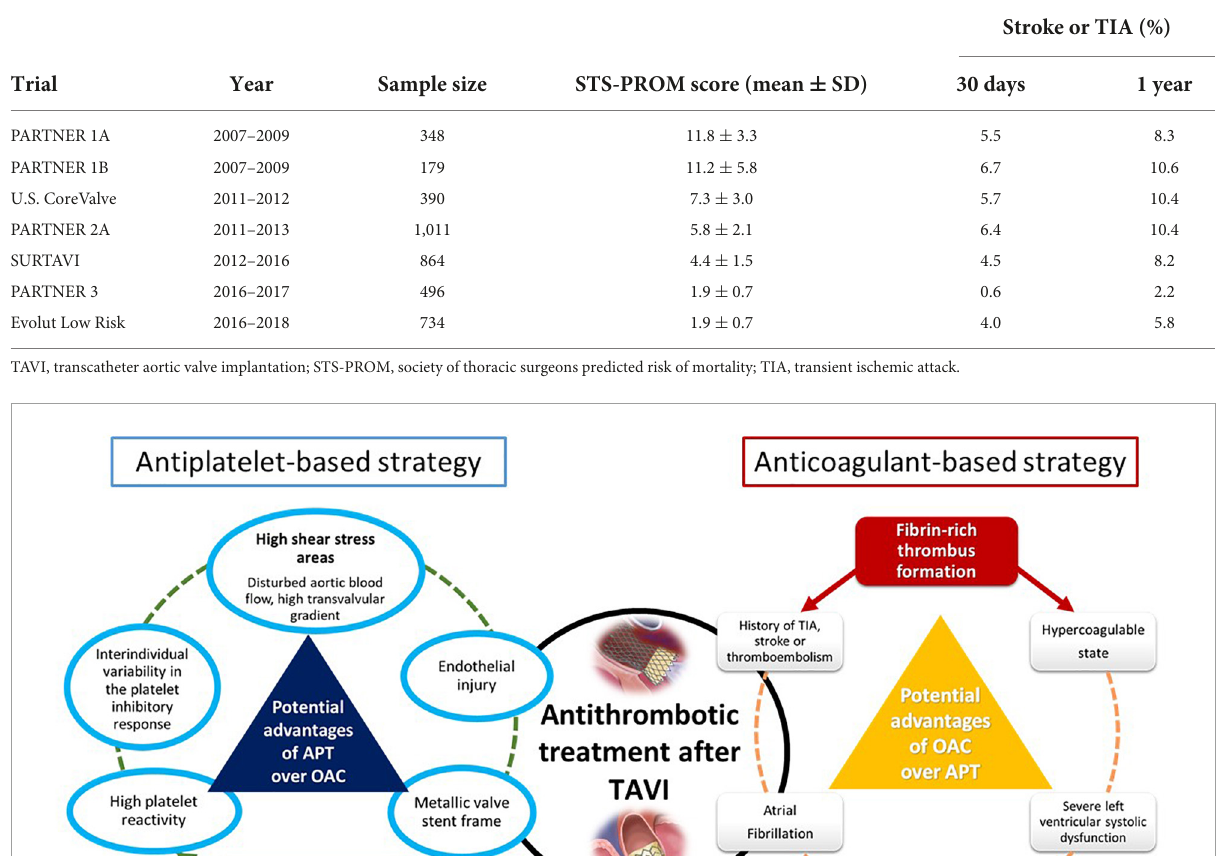
TABLE 1 Rates of stroke/TIA in the pivotal randomized TAVI trials.